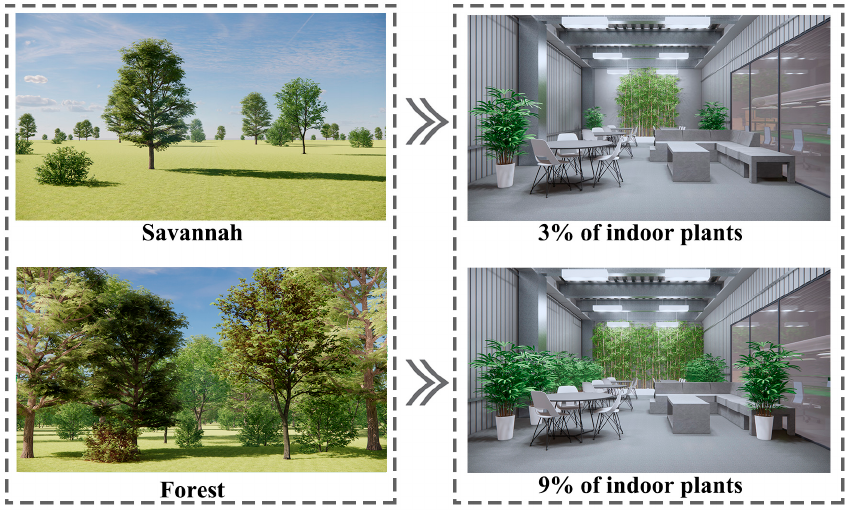
Figure 13. Application of the savannah hypothesis to the volume ratio of indoor plants.